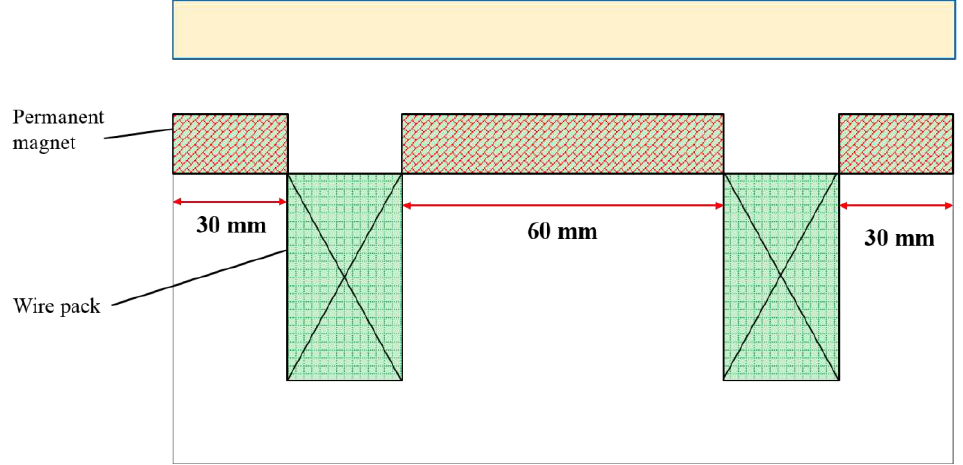
Figure 3. Structure of permanent and electromagnet hybrid actuator.